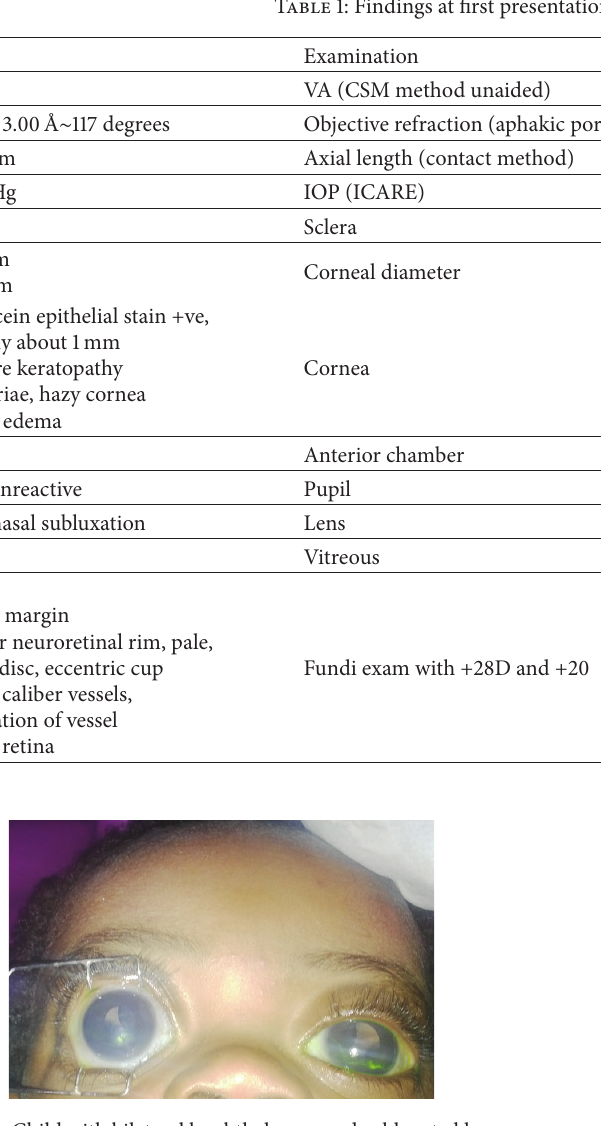
Figure 1: Child with bilateral buphthalmous and subluxated lenses.